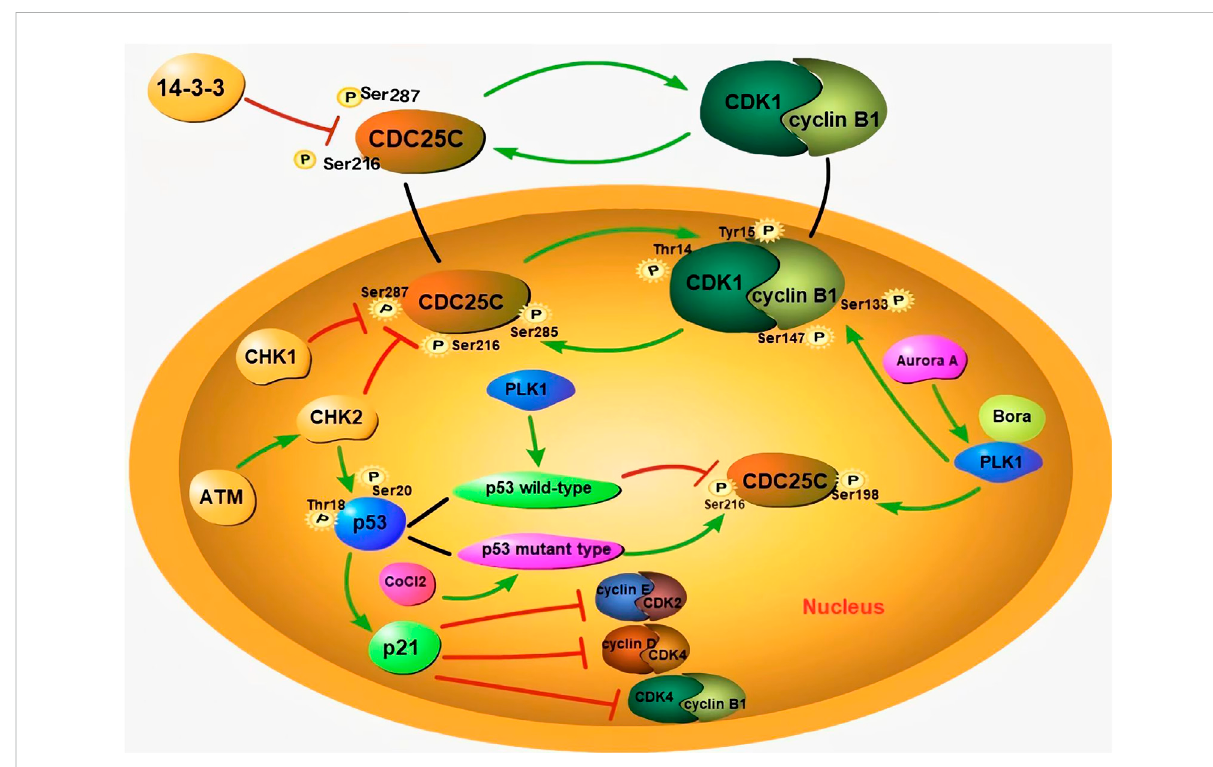
FIGURE 2 The formation of PGCCs is associated with aberrant expression subcellular localization of cell cycle-related proteins. During interphase, the phosphorylation of CDC25C at Ser216 and Ser287 sites can prevent the activation of CDC25C, by binding to 14-3-3 protein, to localize it in the cytoplasm. When CDC25C is activated, it can dephosphorylate CDK1 and activate nuclear entry of cyclin B1/CDK1. The phosphorylation site of CDC25C is associated with different p53 genotypes. Wild-type p53 can inhibit the phosphorylation of CDC25C-Ser216, while mutant-type p53 can promote the same. The bind of p21 with cyclin E/CDK2 and cyclin D/CDK4 complexes can result in cell cycle G1 arrest. In addition, ATM activates CHK2, and results in the phosphorylation of CDC25C-Ser216. Phosphorylated CDC25C-Ser216 can combine with 14-3-3, to promote the cytoplasmic translocation of CDC25C. CHK2 is also able to phosphorylate P53, to promote the accumulation of p21 and maintain G2/M arrest. With theassistance ofBora,Aurora Aphosphorylates PLK1, andpromotesthenuclear localization ofCDC25C. PLK1can also phosphorylate thecyclinB1/ CDK1 complex and promote its entry into the nucleus. Green arrows represent potentiation, while red lines represent inhibitive